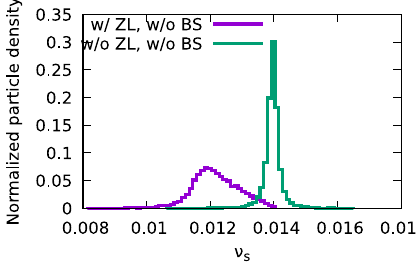
FIG. 7. Incoherent synchrotron tune with and without longi- tudinal wake (ZL), where beamstrahlung (BS) effect is turned off. The stable equilibrium bunch length and energy spread is same betweenthetwocases,where σ z; and σ p; aretunedinlattercase. SR SR